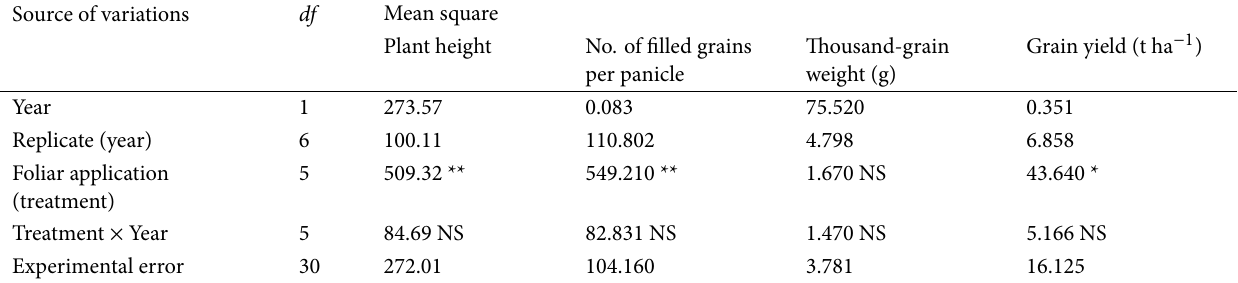
Table 1 Analysis of variance of some traits of the Sahel variety in foliar application treatments. Source of variations df Mean square Plant